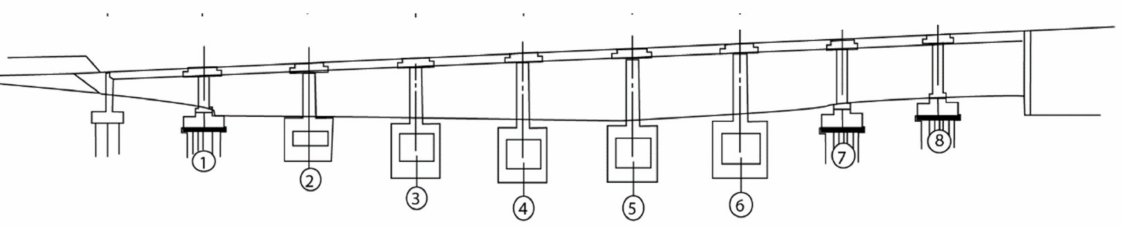
Figure 2. Longitudinal section of the examined viaduct, with the five (central) piers founded on caissons and the three (lateral) piers founded on piled rafts—sketch modified from the original project, 1981.